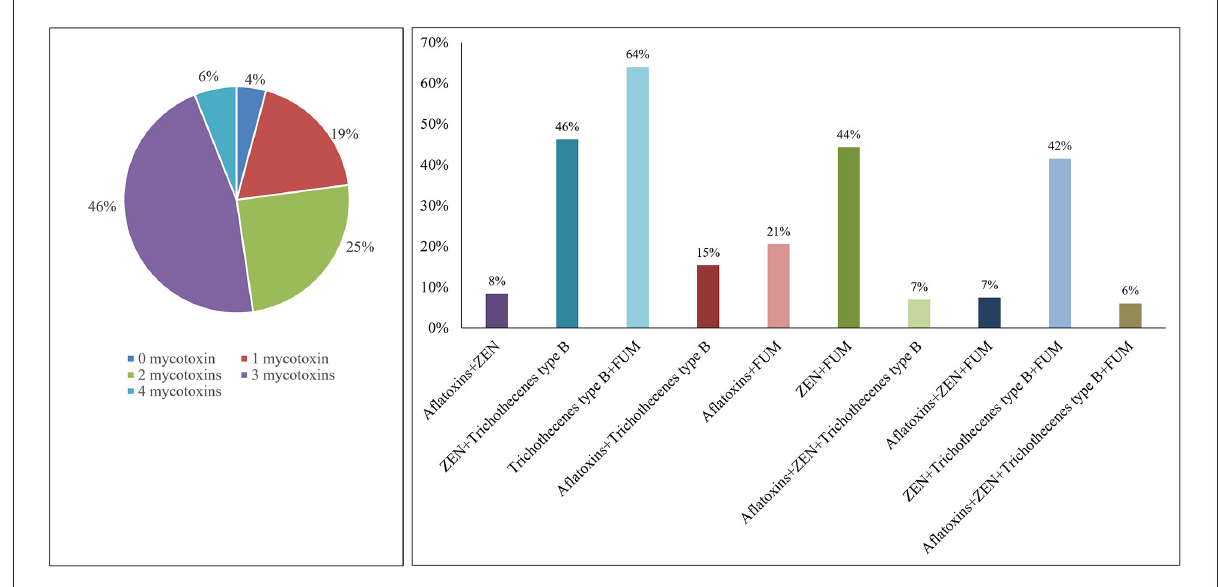
FIGURE1 Mycotoxin co-occurrence in new season